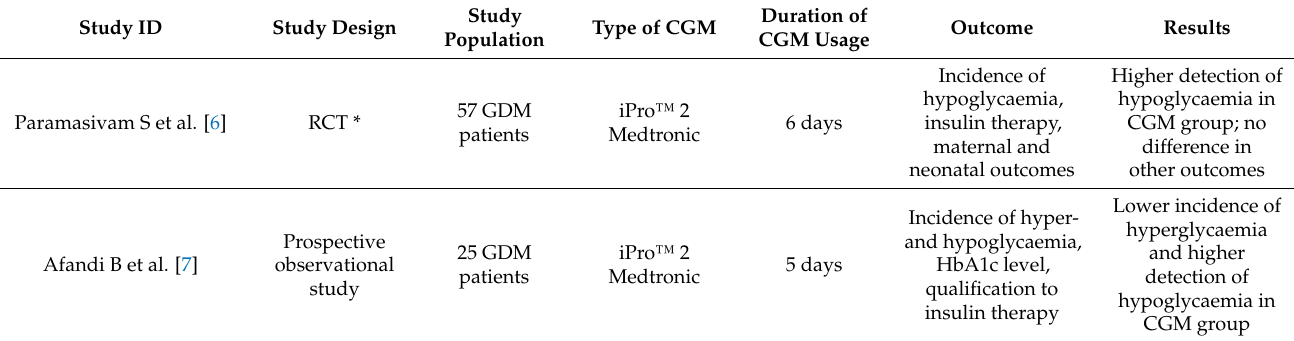
Table 2. Characteristics of studies included in the systematic review.